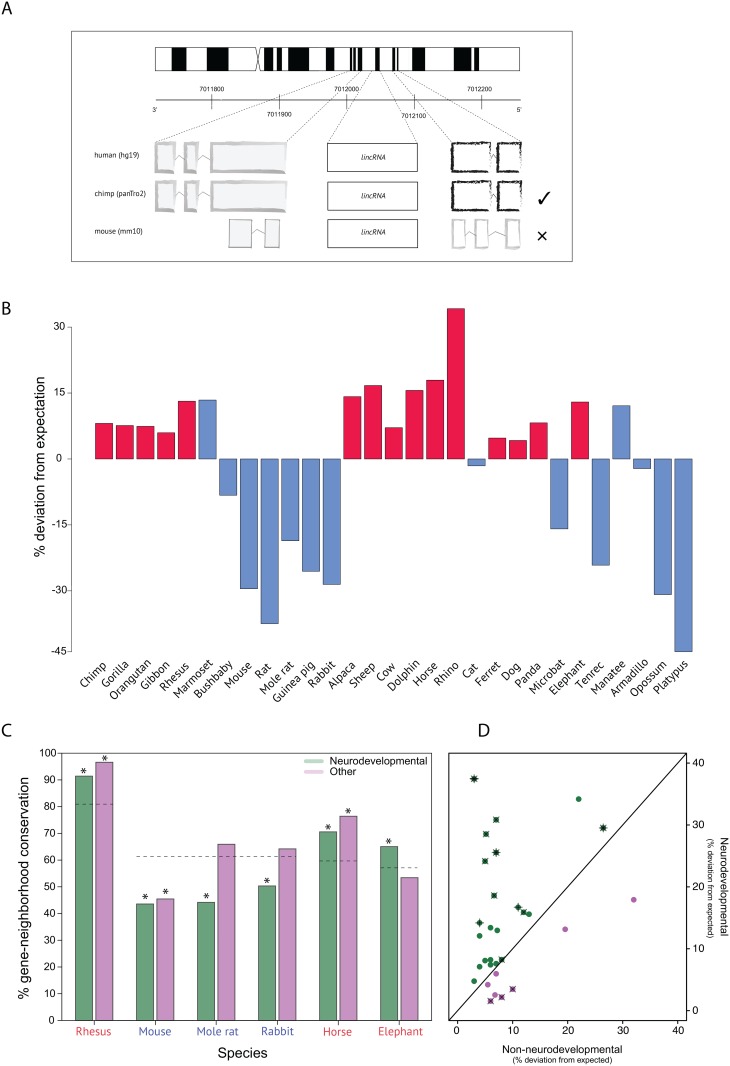
LincRNA gene-neighborhood conservation in neurodevelopmental and non-neurodevelopmental tissue.(A) Schematic of the protocol used for determining lincRNA gene-neighborhood conservation across species. In the example given, only chimp is scored as conserved. Chromosomal synteny is not a condition for gene-neighborhood conservation. (B) Gene-neighborhood conservation of 142 lincRNAs expressed during human neurogenesis across 29 mammalian species (S2 Table). Gene-neighborhood conservation is shown to be above null phylogenetic expectations in high-GI species (red) and below expectations for low-GI species (blue). The two exceptions are the marmoset, a low-GI primate, and the manatee, a large-brained lissencephalic Afrotherian; both of these show lincRNA gene-neighborhood conservation considerably above null expectations The chicken is not shown. (C) Gene-neighborhood conservation for neurodevelopmental lincRNAs (green) and lincRNAs showing maximum levels of expression in non-brain human tissue (lilac) for three high-GI (red) and three low-GI (blue) species. Conservation in the naked mole rat, rabbit, and elephant are significantly different for neurodevelopmental compared to non-brain (Other) lincRNAs, while similar levels of conservation are observed for both classes of lincRNAs in macaque, mouse, and horse. Predicted conservation values for each species (dashed lines) were calculated from null evolutionary models based on divergence times with human. Asterisks denote significantly different values from predicted (P < 0.05). (D) Plot of neurodevelopmental versus non-neurodevelopmental (absolute) conservation deviation scores based on a phylogenetic expectation model (see Materials and Methods) for 29 mammalian species. From the regression slope delineating no deviation from expected scores, it is clear that neurodevelopmental lincRNAs deviate more frequently and more sizeably from conservation expectations than non-neurodevelopmental lincRNAs. Crosses and Xs indicate negative deviations for neurodevelopmental and non-neurodevelopmental lincRNAs, respectively. (B) is adapted from [20].